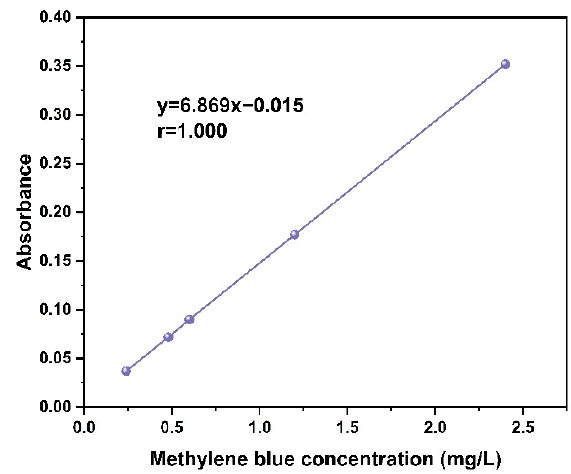
Figure 1. Standard curve of methylene blue.